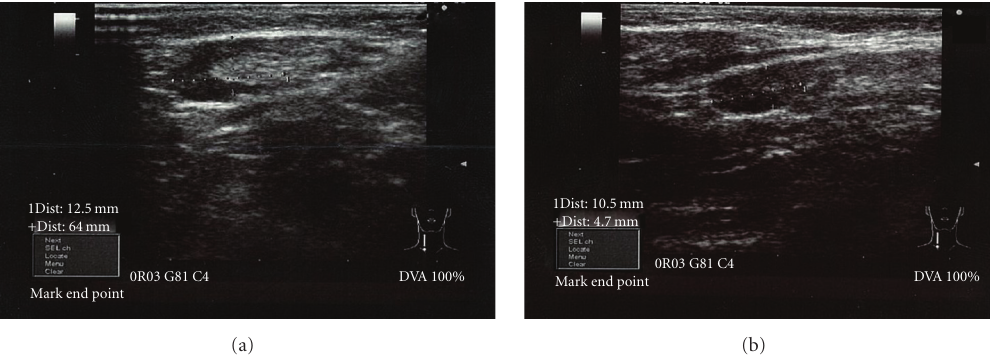
Figure 2: USG scans of the right axillary area taken 2 weeks after the vaccination on the 22nd of December 2009.